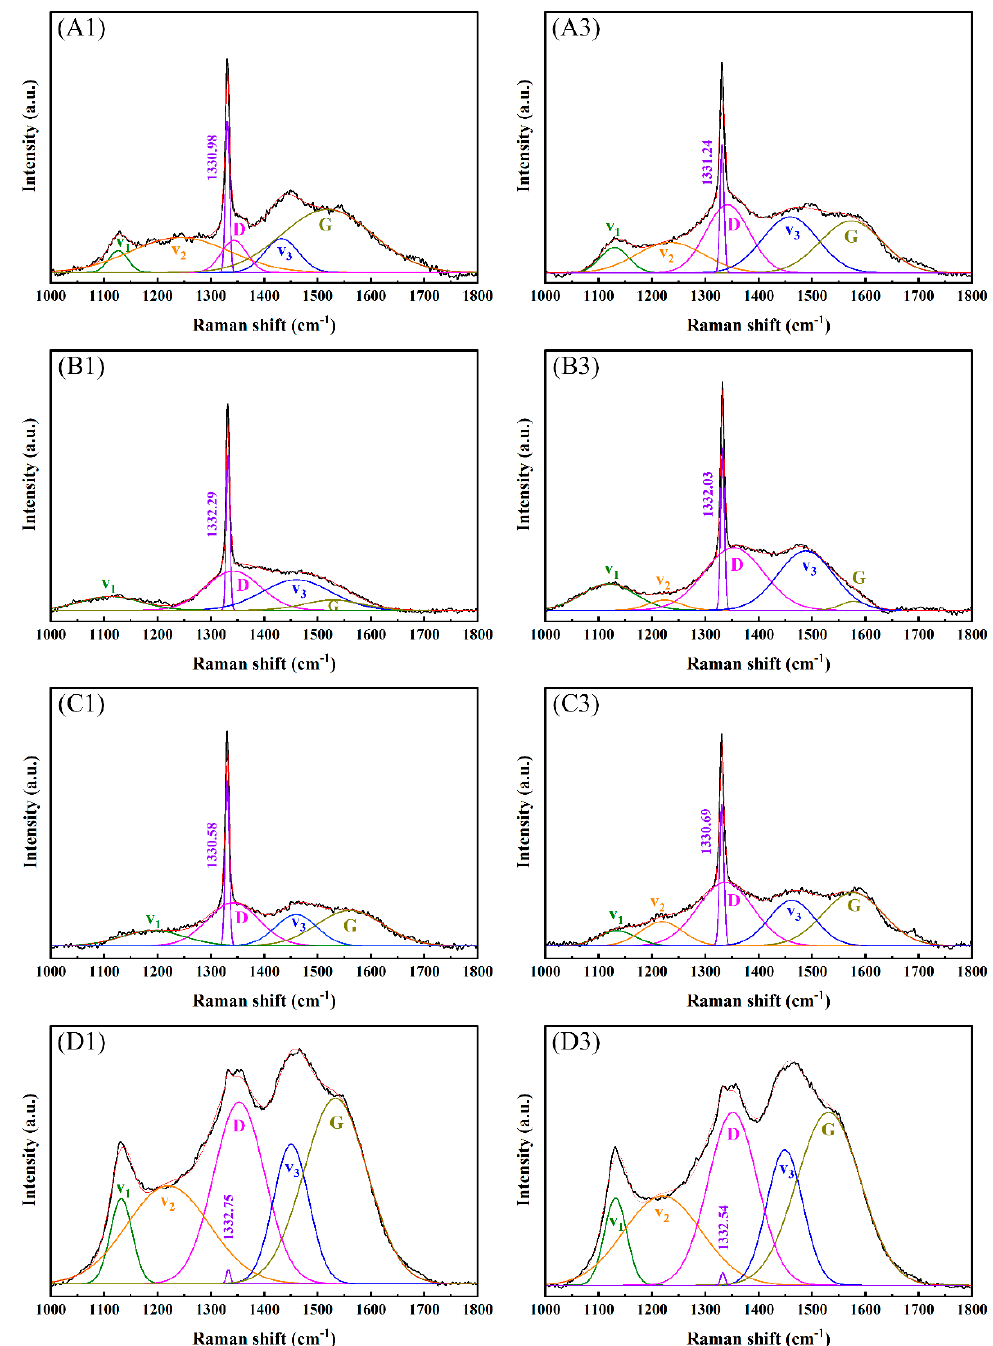
Figure 4. Raman spectra of diamond films deposited at different deposition parameters.